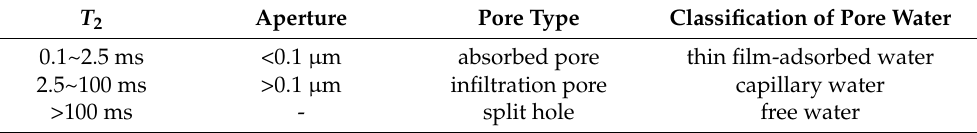
Table 5. Corresponding relation between transverse relaxation time T 2 and pore-throat diameter.